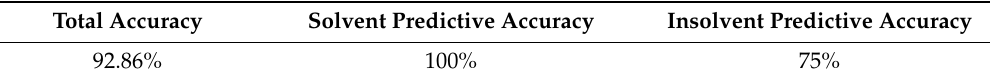
Table 3. Overall accuracy of SVMLK on the testing dataset.